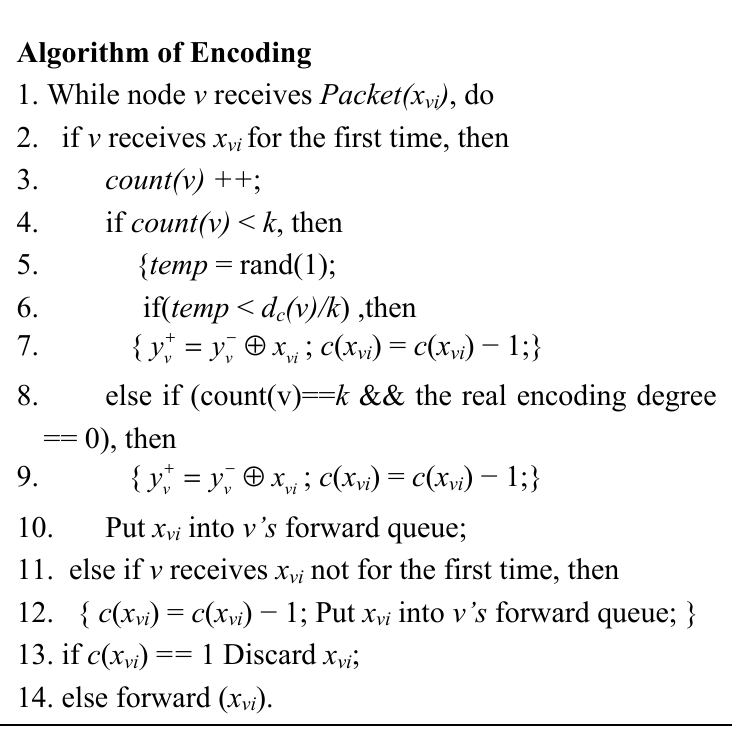
Algorithm 2. Encoding algorithm.